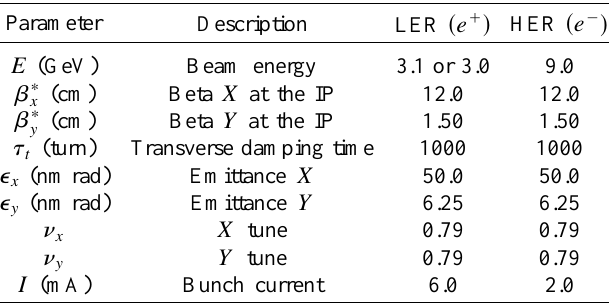
TABLE III. Parameters for the coherent